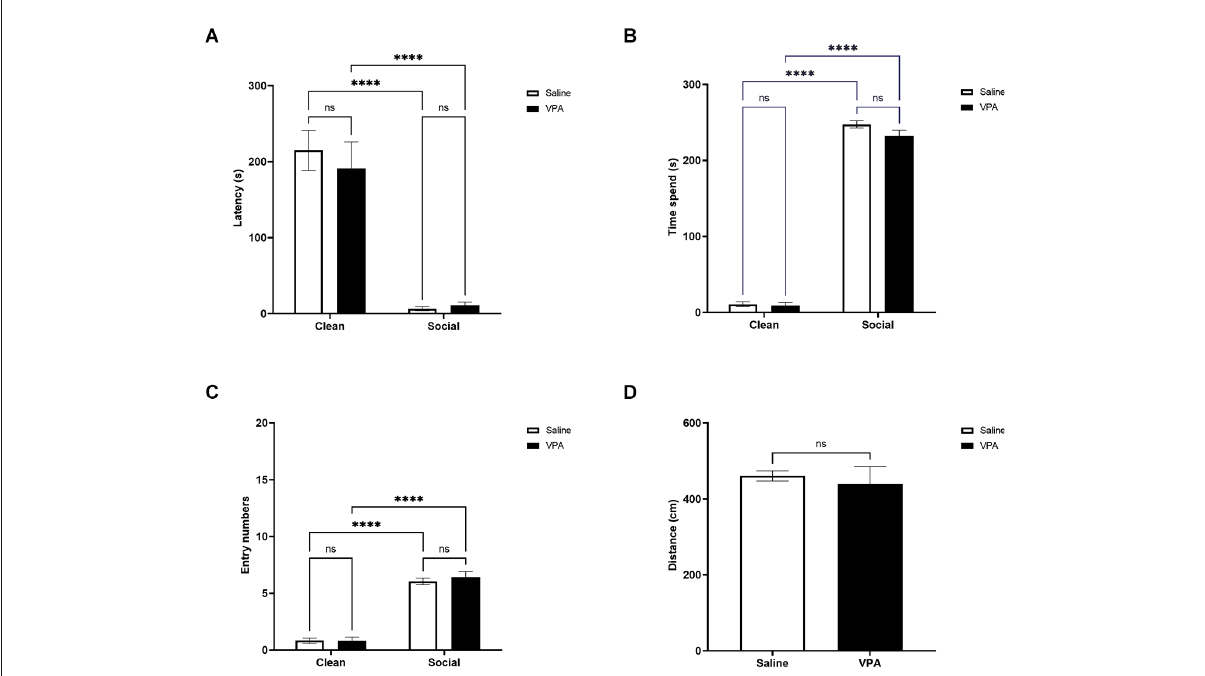
FIGURE3 (A) P13: latency to enter zones. Data expressed as mean ± standard error of the mean. We observed a significant main effect of bedding type, p < 0.0001. Both VPA-exposed and saline exposed-pups showed a shorter latency to enter the social bedding zone than the clean bedding zone, p ’s < 0.0001. (B) P13: time spent in zones. Data expressed as mean ± standard error of the mean. We observed a significant main effects of bedding type, p < 0.0001. Both VPA-exposed pups and saline-exposed pups spent significantly more time in the social bedding zone than the clean bedding zone, p ’s < 0.0001. (C) P13: number of zone entries. Data expressed as mean ± standard error of the mean. We observed a significant main effects of bedding type, p < 0.00001. VPA-exposed pups and saline-exposed pups made significantly fewer entries into the social bedding zone relative to the clean bedding zone p ’s < 0.00001. (D) P13: distance traveled during test. Data expressed as mean ± standard error of the mean. VPA-exposed pups did not differ from saline-exposed pups in their distance traveled during the test, p = 0.64. ∗∗∗∗ p < 0.0001; ns = p >